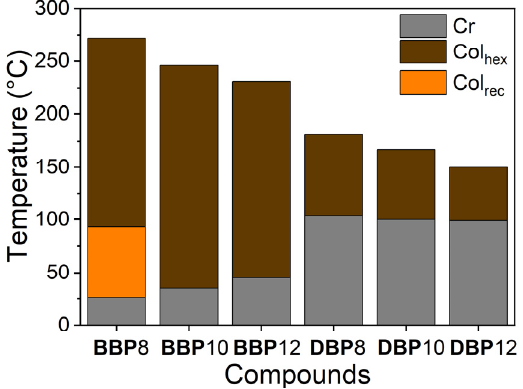
tal ‐ to ‐ crystal phase transformations (Table S2). Figure 3. Thermotropic mesophases diagram of DBP n and BBP n ; Cr: crystalline phase, Col rec : rec ‐ tangular columnar phase, Col hex : hexagonal columnar